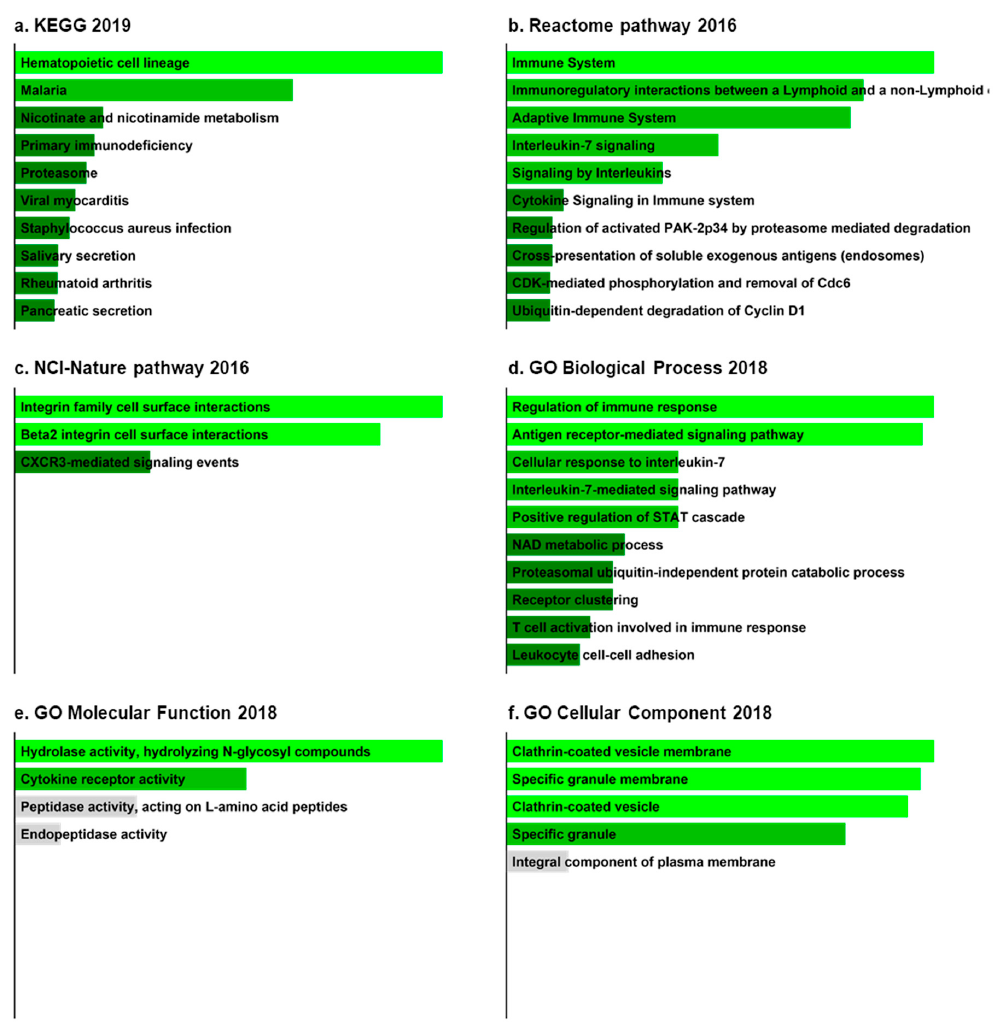
Figure 6. Putative pathways and GO of hub genes in IC / BPS. ( a – f ) Bar graphs indicate the putative pathway acquired from various pathway databases. These results are ranked by p -value. Gray bars denote p -value > 0.05, and the darker colors and the shorter bars have higher p -values.